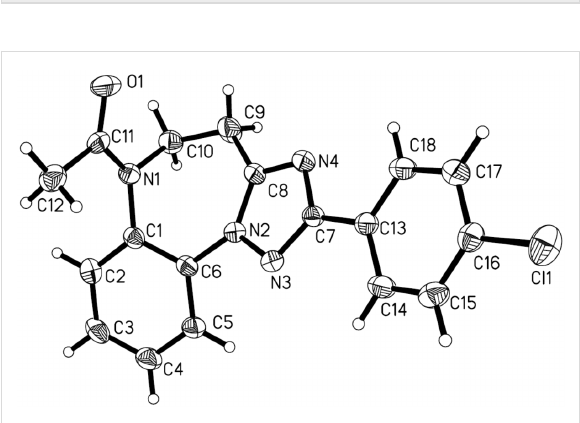
Figure 2: Crystal structure of salt 10k . The displacement ellipsoids are drawn at the 30% probability level.